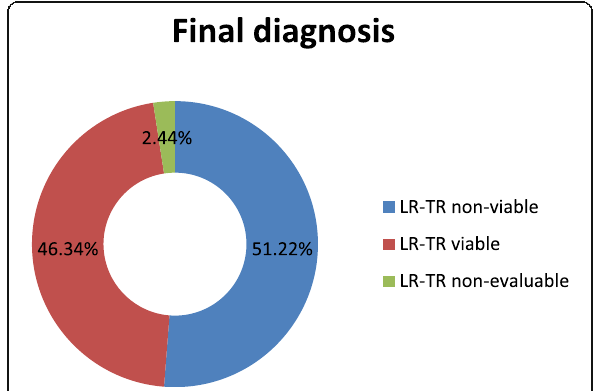
Fig. 5 Distribution of observations into LR-TR viable, LR-TR non- viable, and LR-TR non-evaluable groups